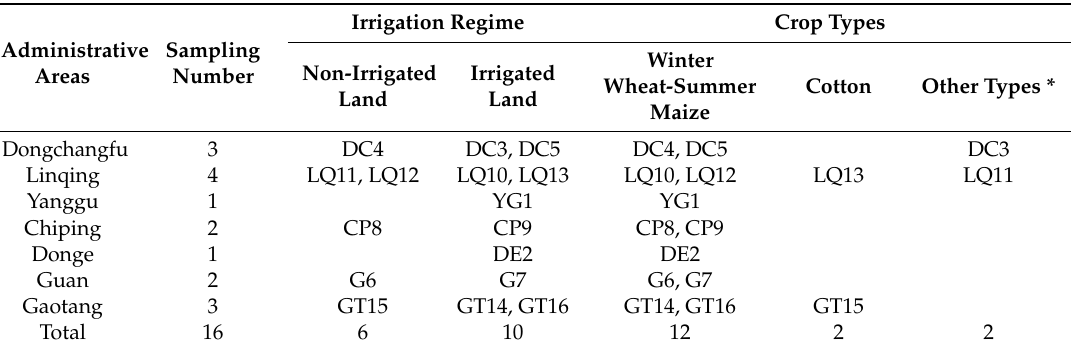
Table 1. Summary of bromide sampling